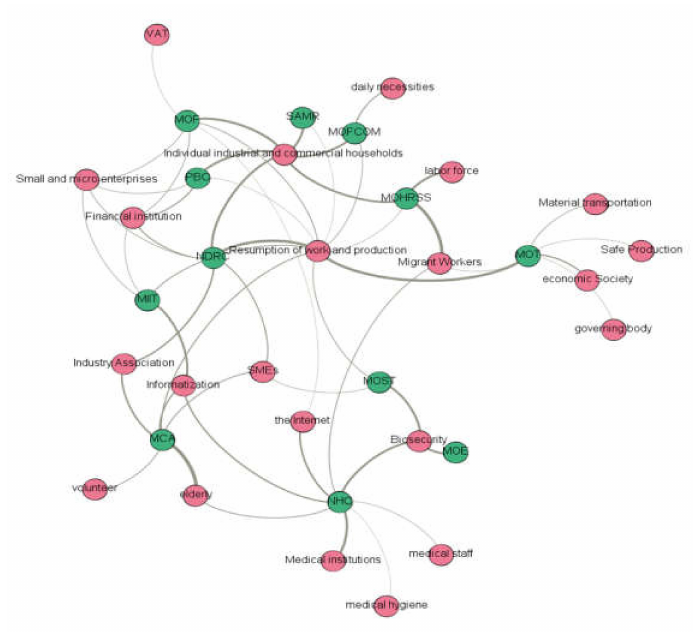
Figure 5. “Agency–topic” relationship network in the second phase. Table 4. Policy topics of interagency collaborative decision-making in the second